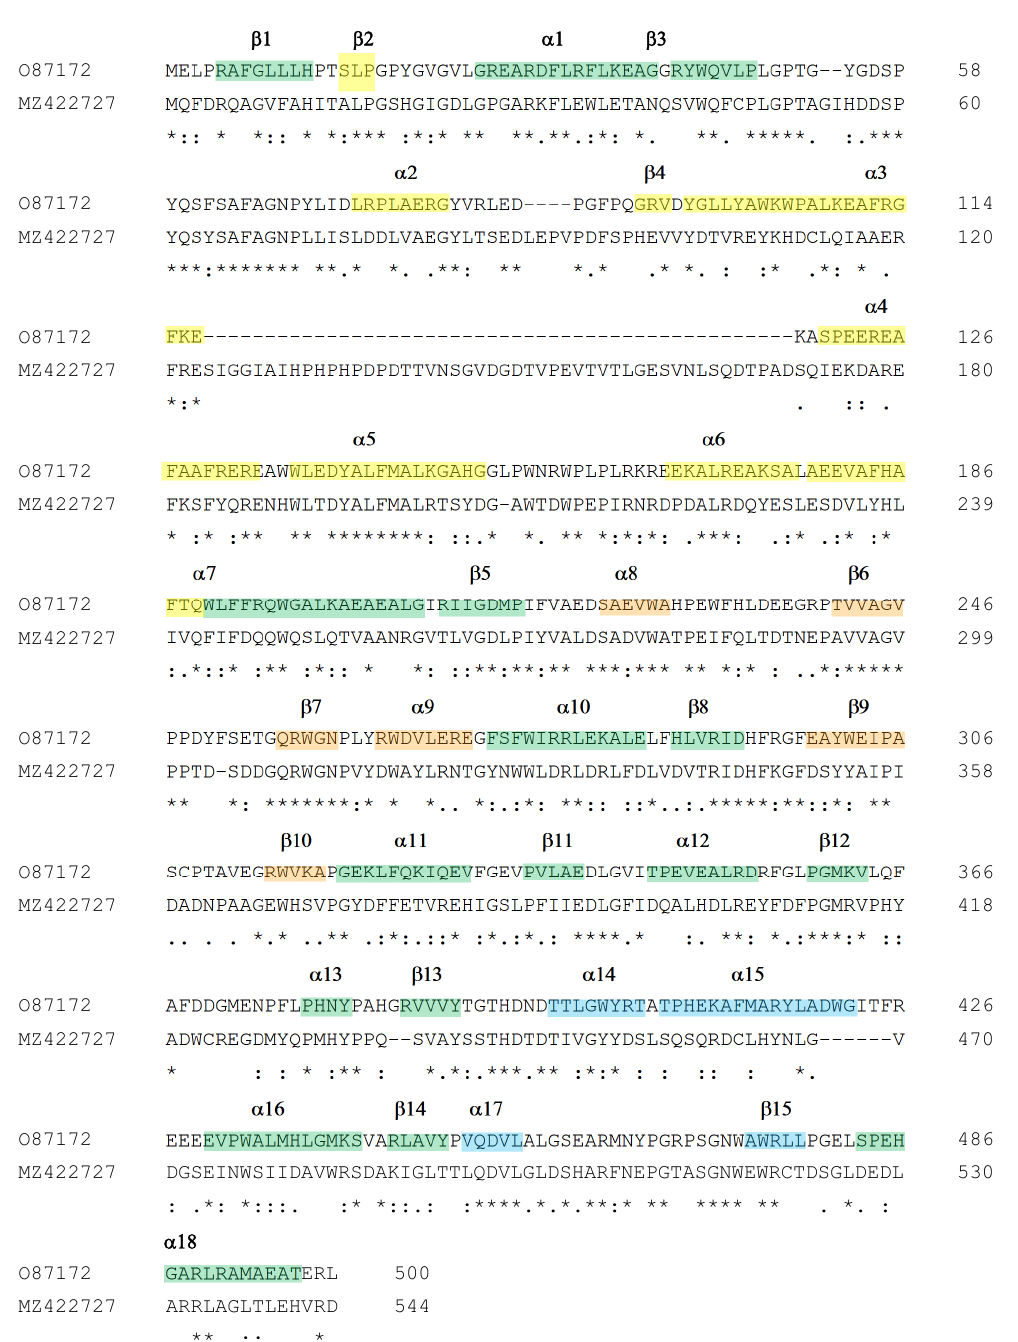
Figure 5. Multialignment of amylomaltases from H. walsbyi (MZ422727) and T. thermophilus (O87172). Sequences of enzymes are indicated by the UniProt accession number for the T. thermophilus enzyme and by the GenBank accession number for the H. walsby enzyme. Other details of the sequences are reported in Table 1. The order of the sequences and amino acid conservation symbols are as obtained by the Clustal program [54] (in particular, asterisks indicate identical residues; colons and dots indicate conserved and semi-conserved substitutions, respectively). Secondary structure description is related to amylomaltase from T. thermophilus according to the 3D structure described by Przylas et al. [51]. In particular, green regions refer to the ( β / α ) 8 TIM barrel (domain A); the other coloured regions correspond to subdomain B1 (orange), subdomain B2 (yellow) and subdomain B3